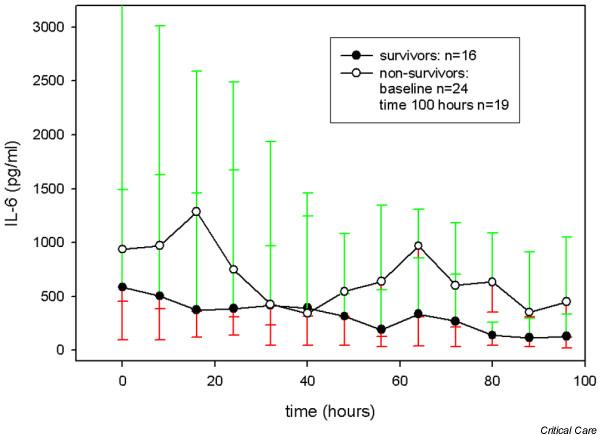
IL-6 for survivors and non-survivors over time.